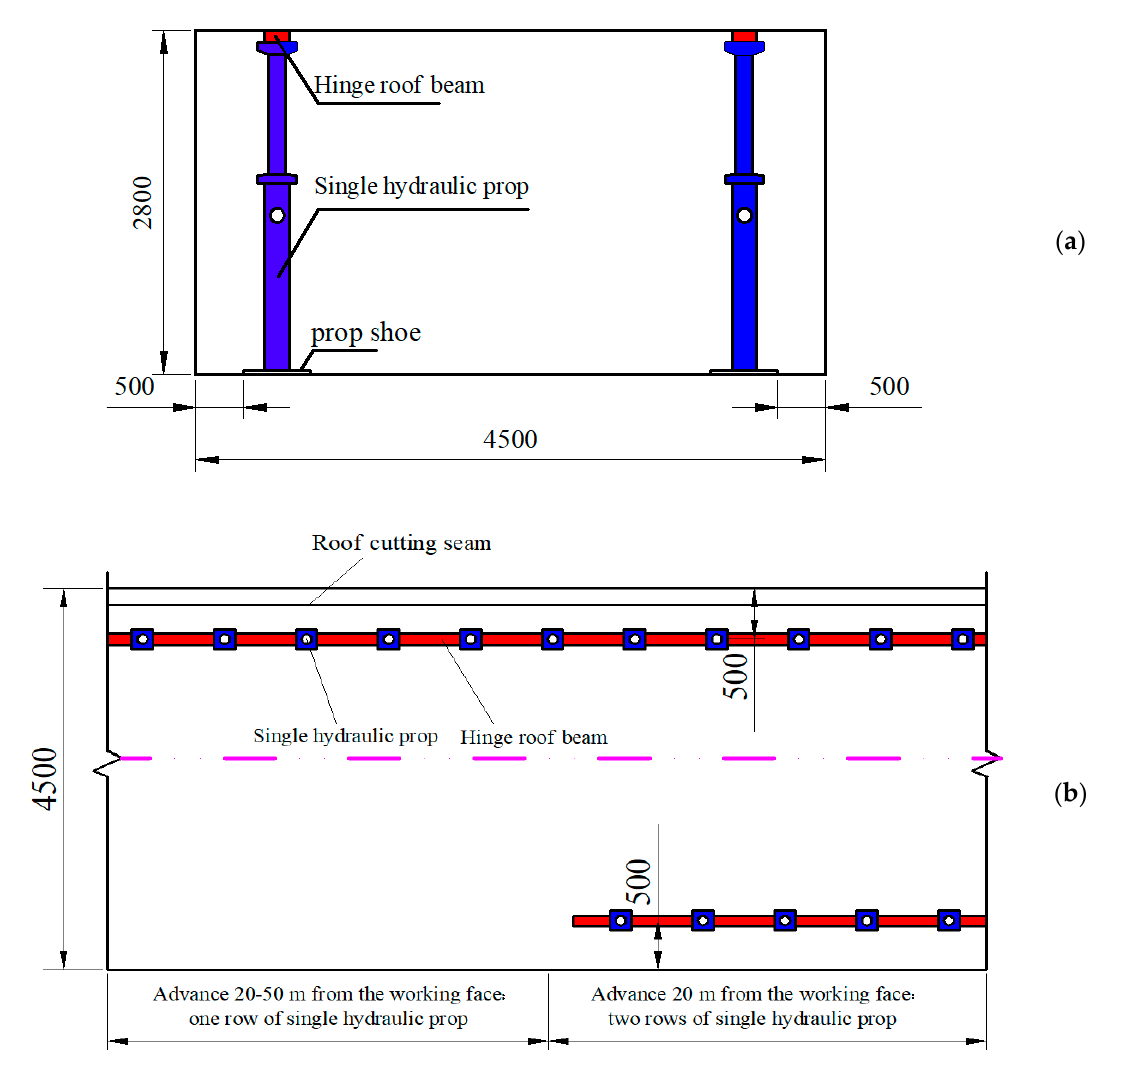
Figure 15. Schematic diagram of the advanced temporary support (unit: mm). ( a ) Support section, ( b ) Support planar.